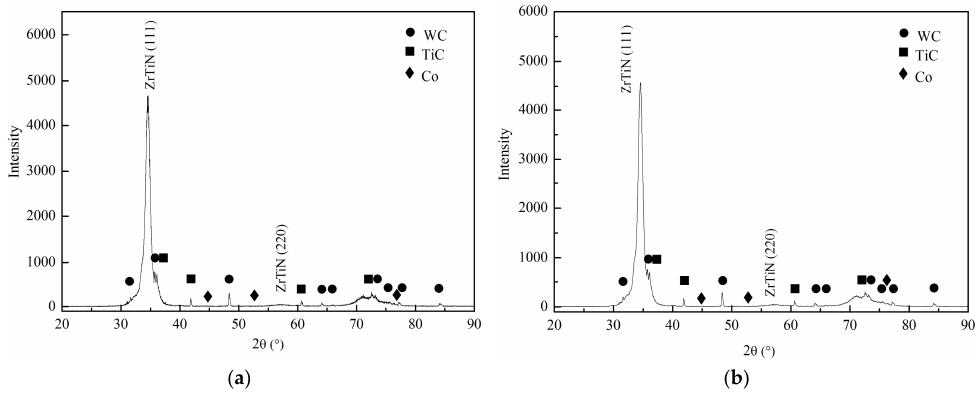
Figure 3. X-ray diffraction analysis of the coatings: ( a ) SZT; ( b ) ZGC.